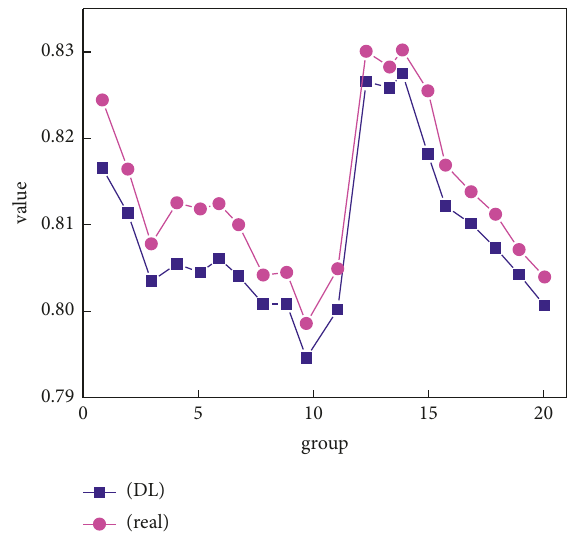
Figure 8: The predicted value of the propagation path feature and the actual value distribution of the feature using atrous convolution and